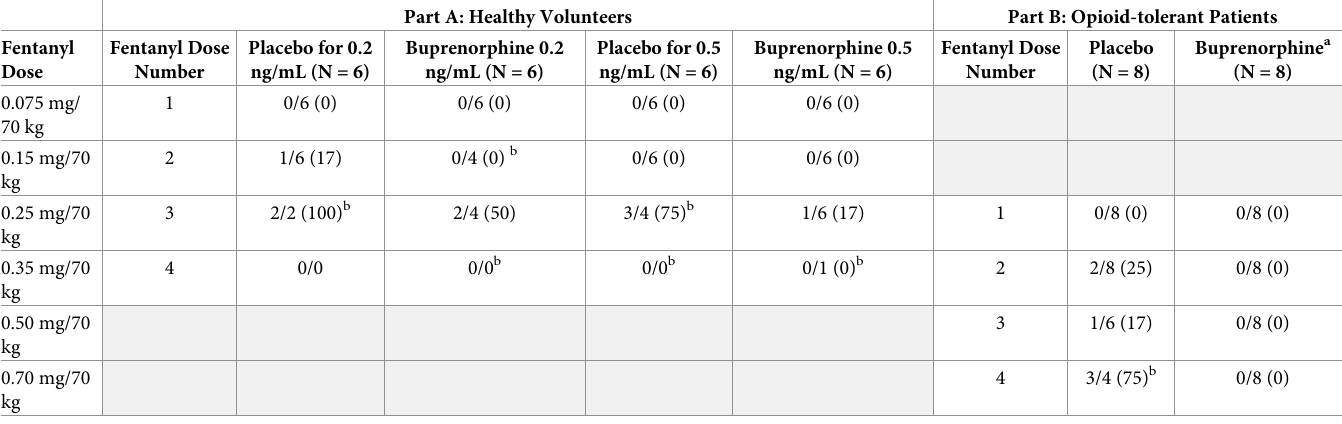
Table 2. Number and percentage of participants who experienced apnea that required stimulation (i.e. persistent apnea). Part A: Healthy